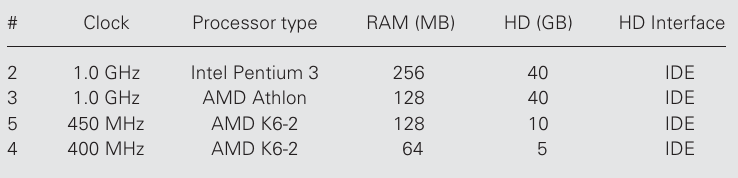
Table 1. Cluster configuration.